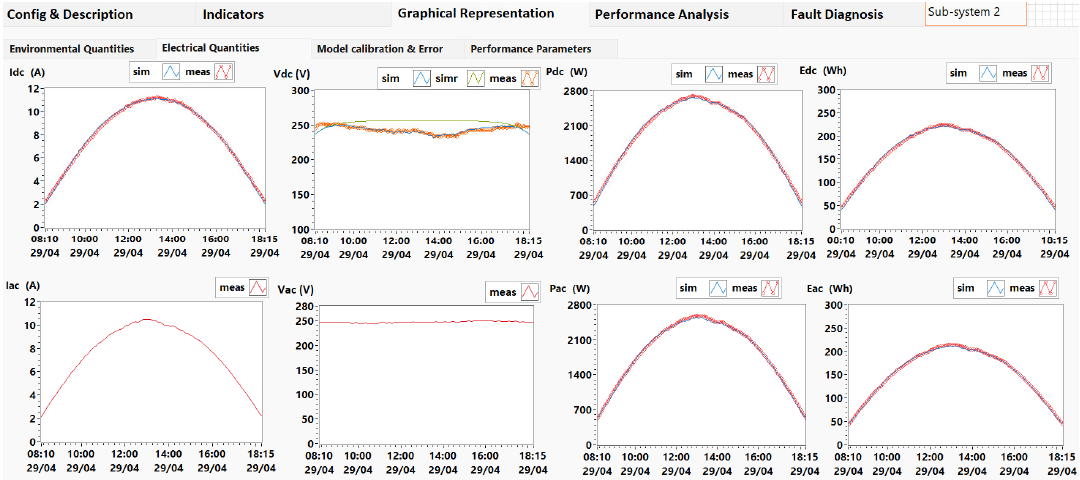
Figure 16. Measurement graphs of tilted irradiances, ambient temperature, and modules temperatures.